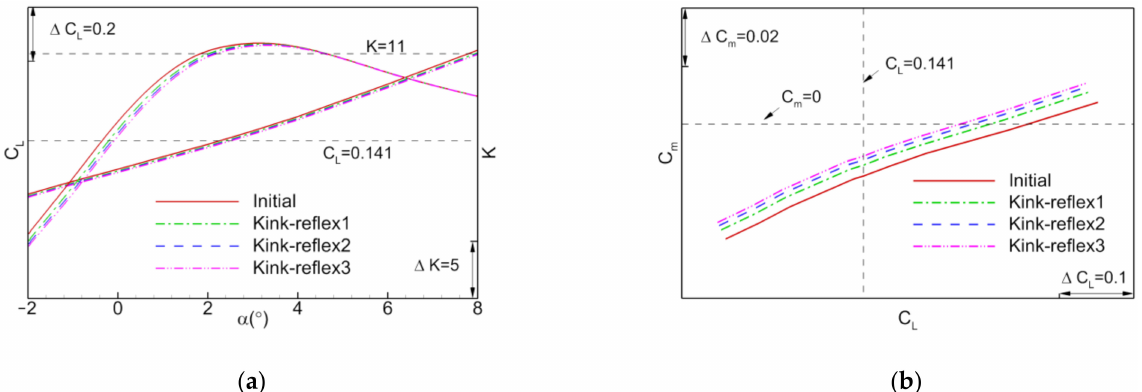
Figure 21. Aerodynamic characteristic of the configurations with different aft-reflexing kink airfoils. Ma = 0.85, H = 11 km, α = − 2 ◦ ∼ 8 ◦ , ∆ α = 2 ◦ . ( a ) Lift coefficient, lift to drag ratio; ( b ) Pitching